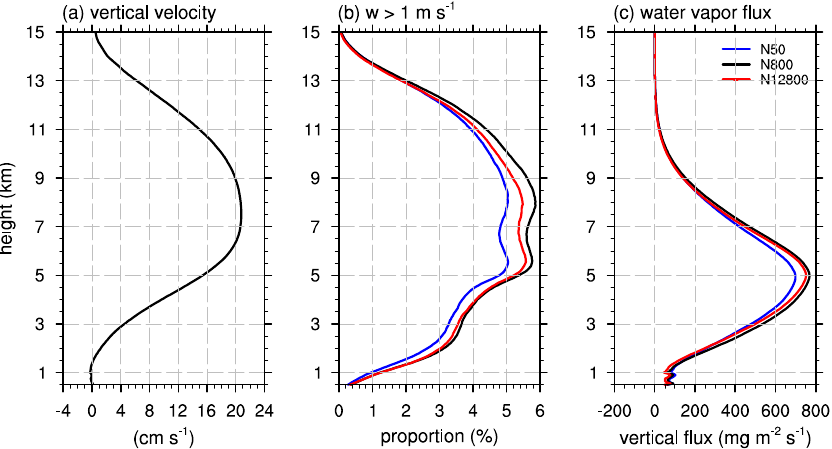
Figure 13. Vertical profiles of ( a ) vertical velocity in the N 0 = 800 cm − 3 case, ( b ) proportions of grid points where the updraft velocity is larger than 1 m s − 1 to all grid points, and ( c ) water vapor vertical flux in the N 0 = 50, 800, and 12,800 cm − 3 cases.